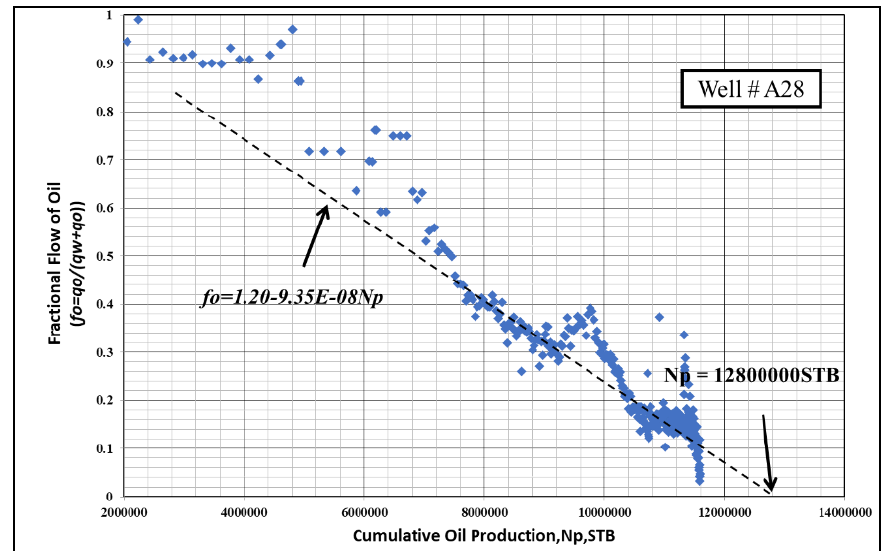
Figure 16. Fractional flow of oil versus cumulative oil production for well